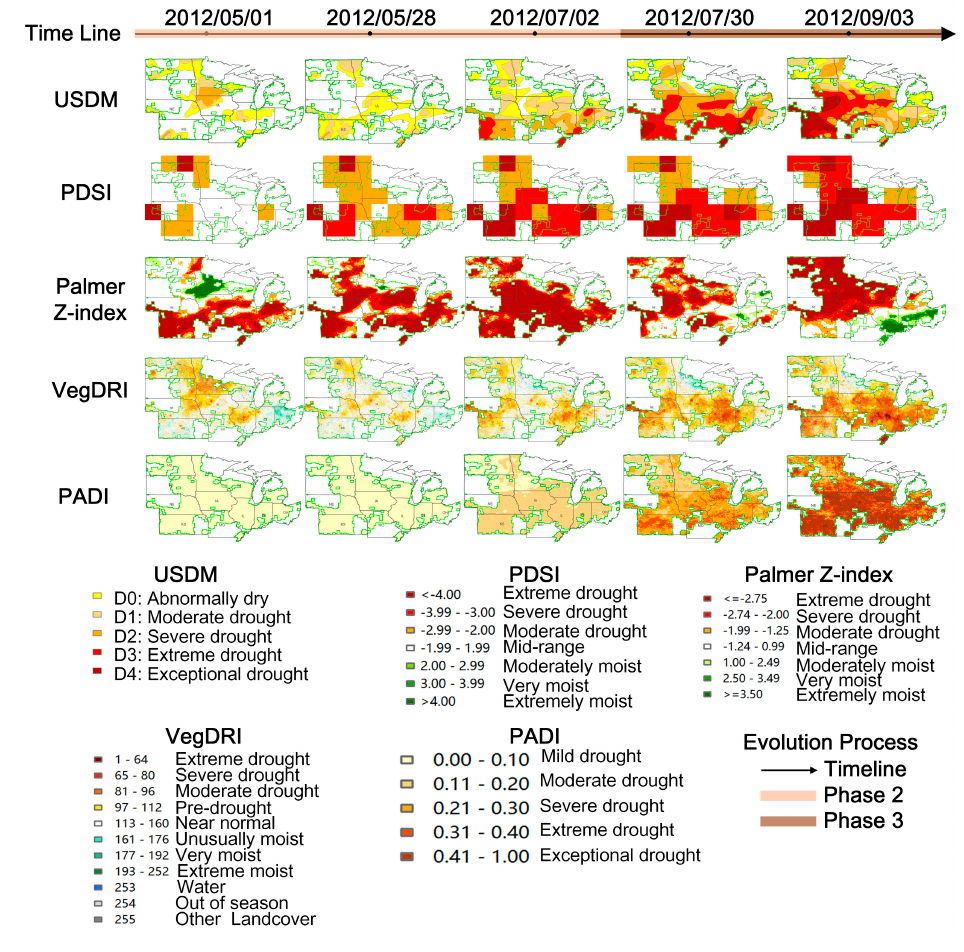
Figure 3. Spatio-temporal distribution of 2012 Midwest drought from the perspective of USDM, PDSI, Palmer Z-index, VegDRI, and PADI.